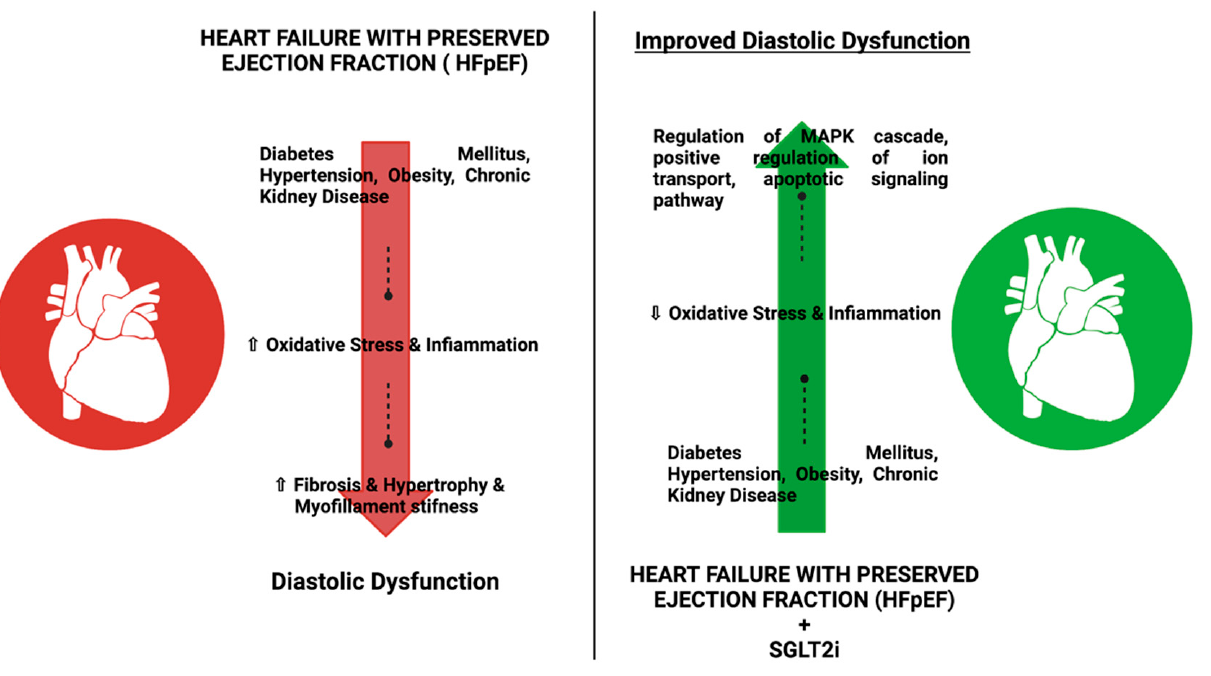
Figure 1. Effect of SGLT2i for the treatment of T2D in patients with HFpEF or HFrEF: The use of SGLT2i has shown improvement in diastolic dysfunction in patients with FHrEF or HF and reduced oxidative stress, infiammation, fibrosis, and myofilament stifness when compared with patients not using SGLT2i.